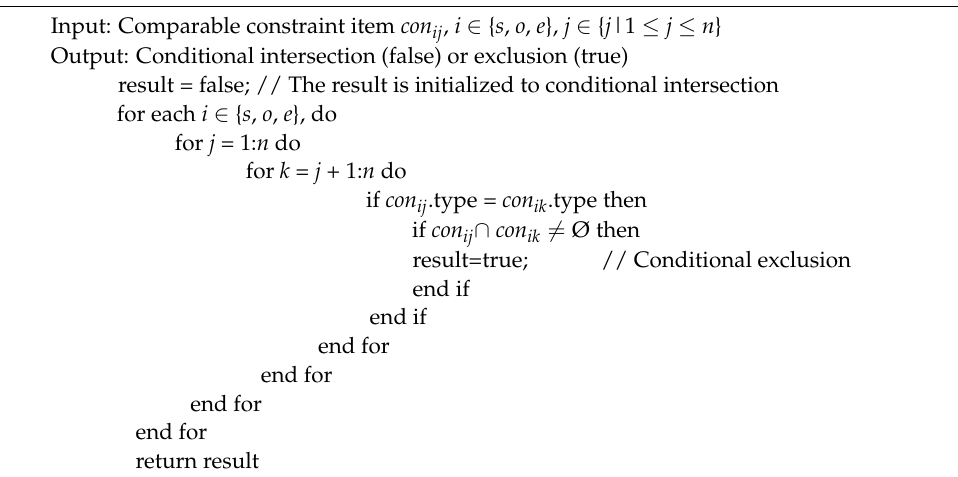
Algorithm 2. The algorithm of conditional compatibility